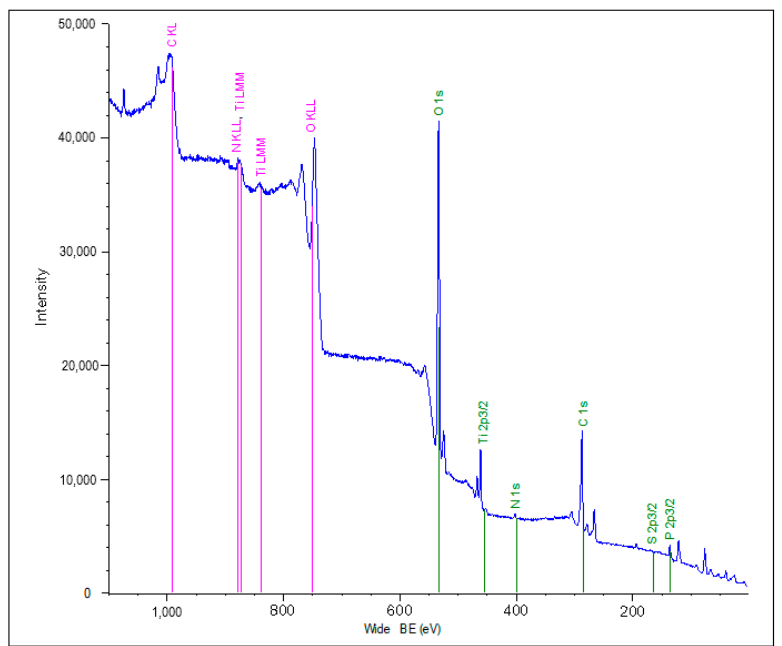
Figure 3. Survey XPS spectra of the CG-Ti-PEO- 6d coating. Table 3. Atomic composition and ratio for the Ti-PEO samples obtained from XPS high-resolution spectra.